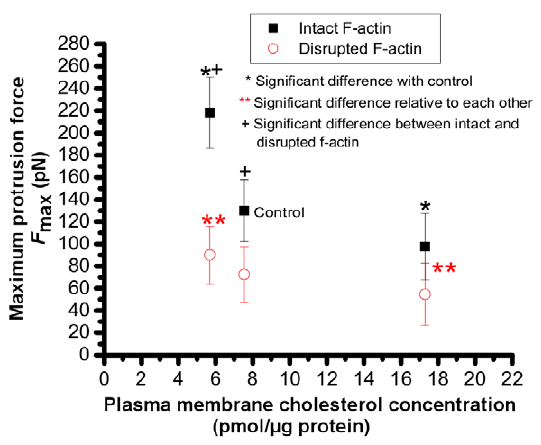
Figure 5. Effect of membrane cholesterol content and cyto- skeletal F-actin on maximum protrusion force. Maximum protrusion force ( F max ) is defined as the force that results in separation of membrane from cytoskeleton.